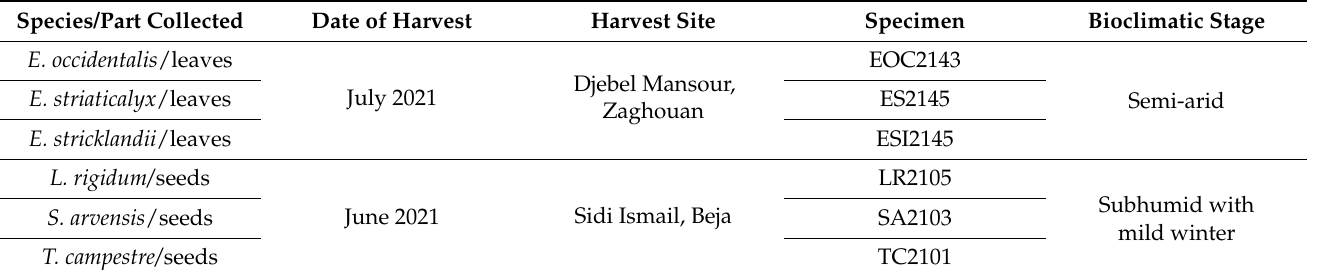
Table 8. Species, date and site of harvest of the plant